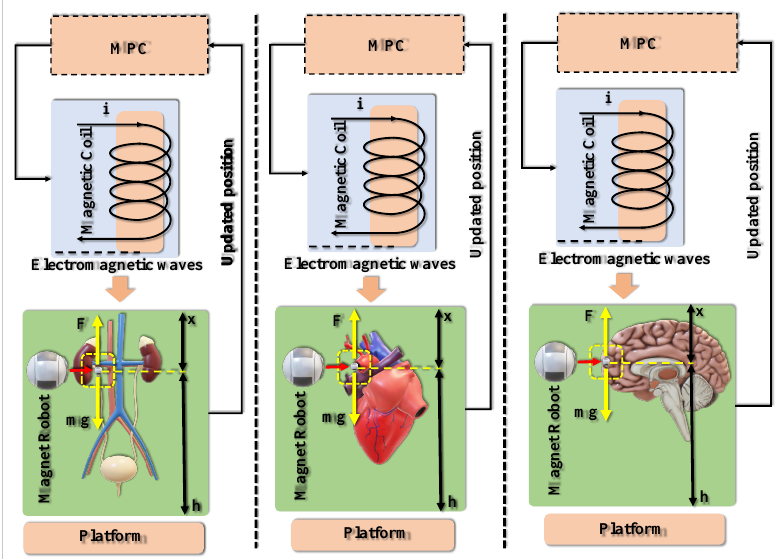
Figure 2. The proposed magnetic microrobot for different purposes in a healthcare system.